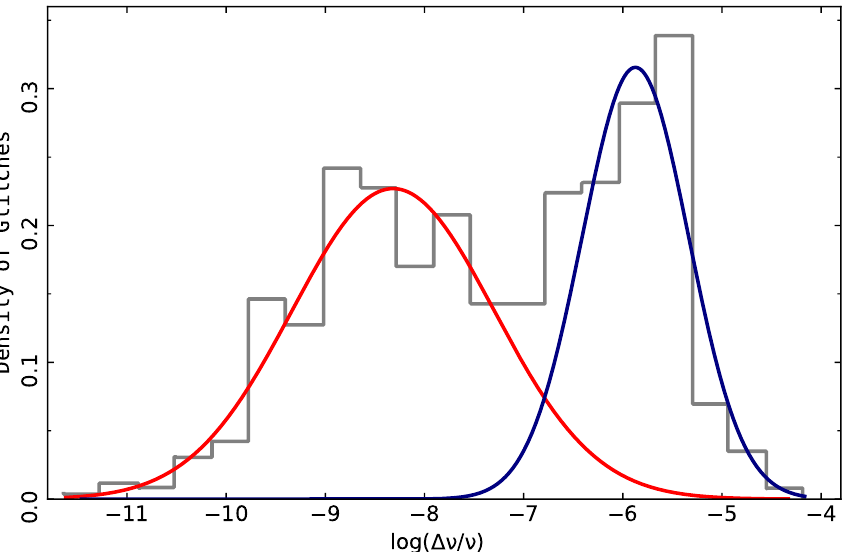
Figure 10. Normalized histogram of the pulsar glitches amplitudes log( ∆ ν / ν ) [33]. There are 390 glitches which belong to the first component and 310 to the second component. The narrower Gaussian component (navy) centred at 1.3 × 10 − 6 represents the large glitches, whereas the wider Gaussian component (red) centred at 5.9 × 10 − 9 represents the smaller